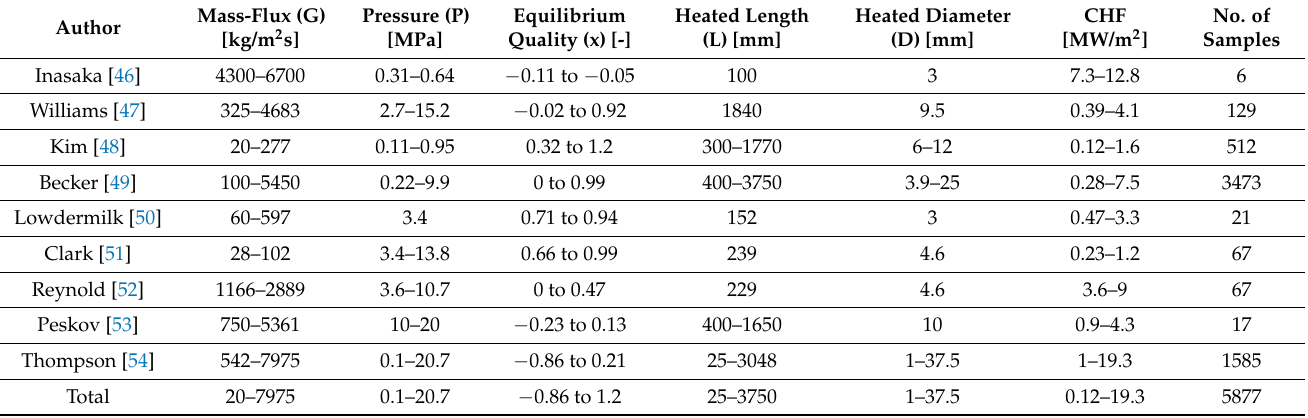
Table 1. Experimental ranges of CHF